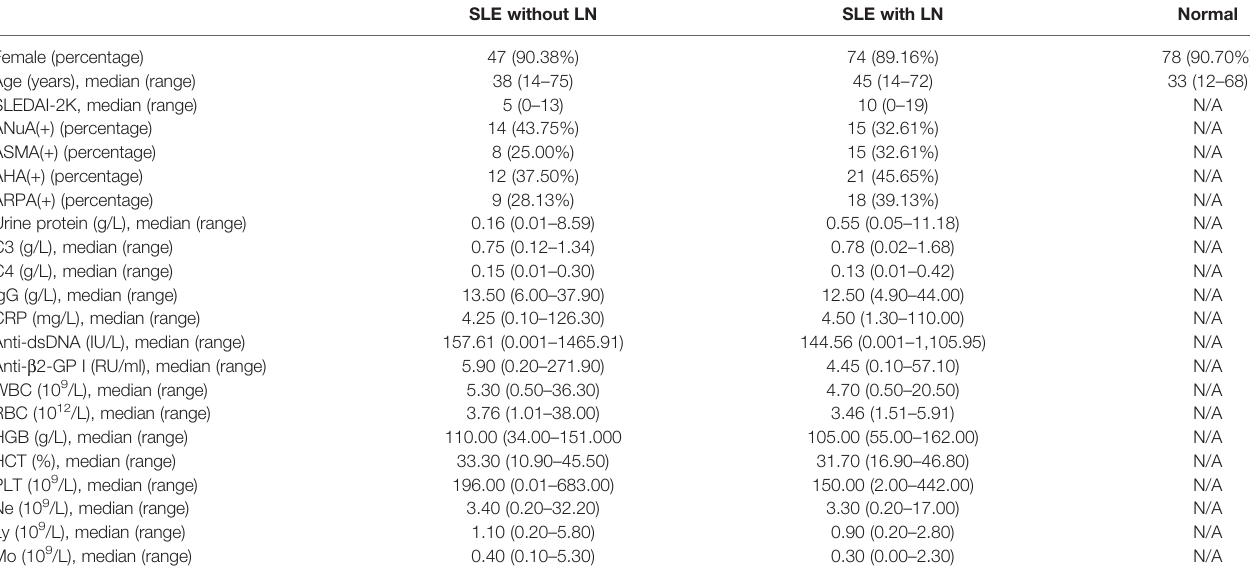
ANuA, anti-nuclear antibody; ASMA, anti-Smith antibody; AHA; anti-histone antibody; ARPA, anti-ribosomal p protein antibody; C3,Complement C3;C4, Complement C4; IgG, immunoglobulin;CRP,C-reactiveprotein;WBC,whitebloodcell;RBC,redbloodcell;HGB,hemoglobin;HCT,hematocrit;PLT,platelet;Ne,Neutrophils;Ly,lymphocyte; Mo,monocyte; N/A, not